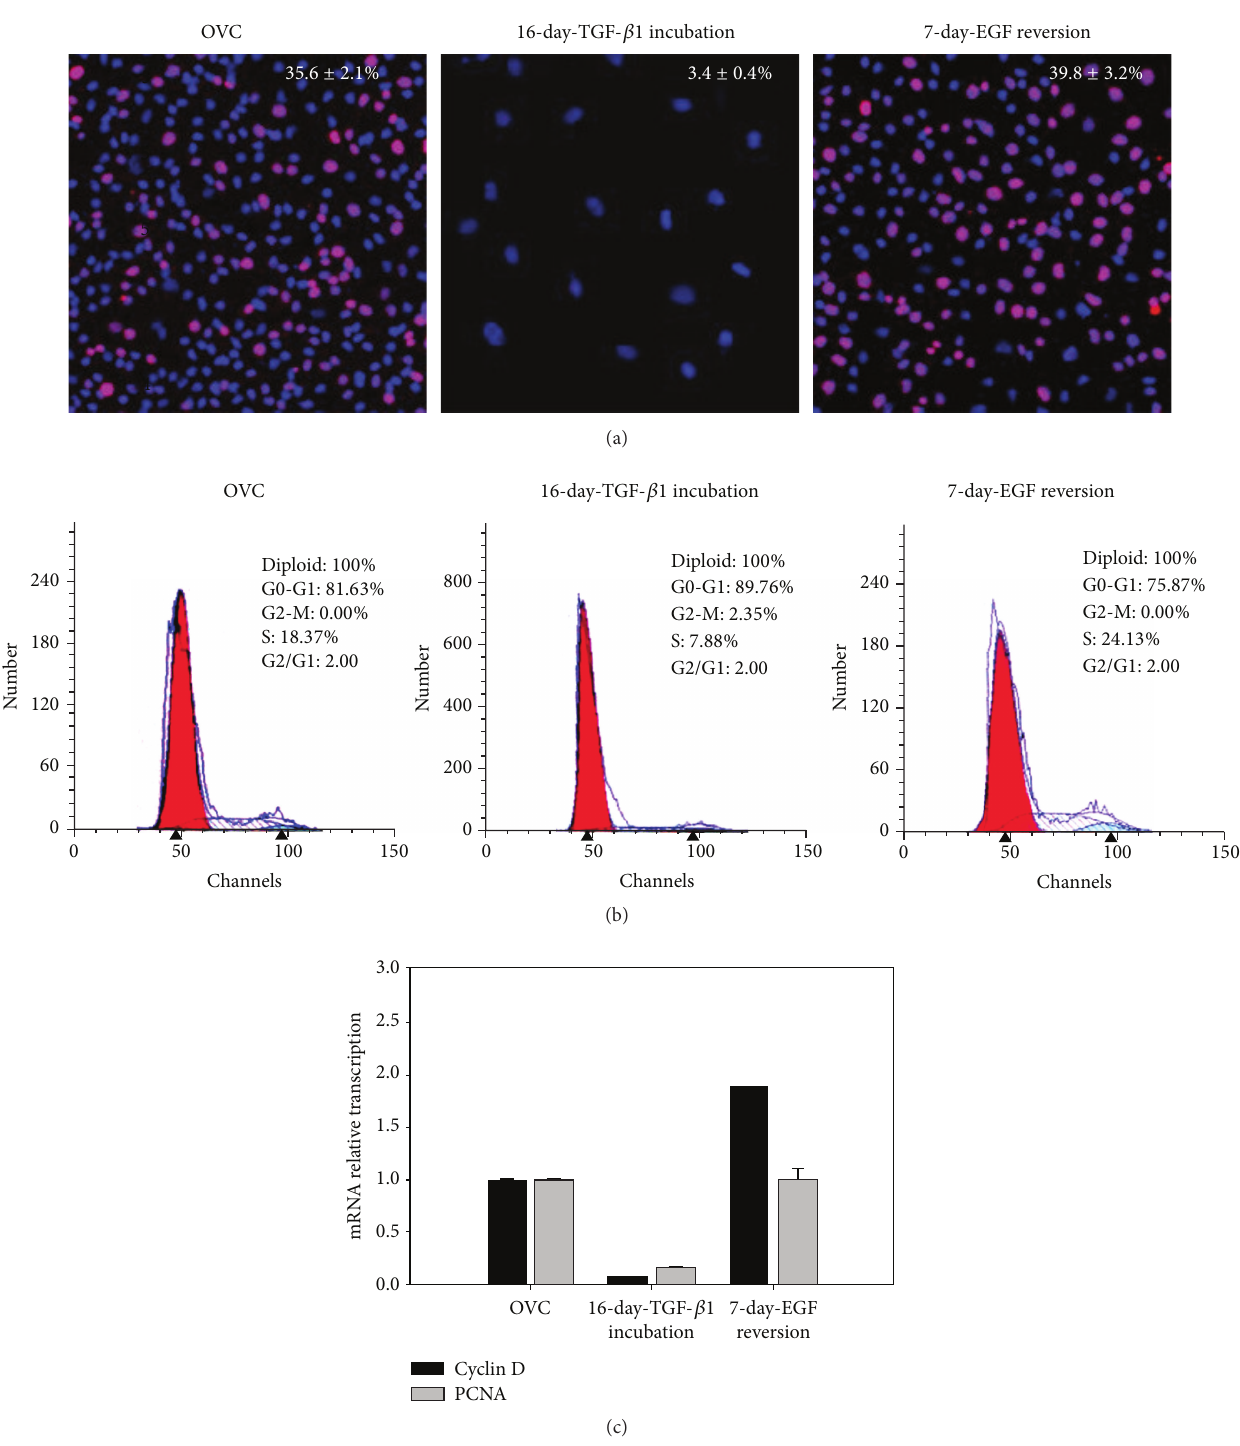
Figure 3: Seven-day EGF incubation restores the proliferation capacity of hepatic oval cells, which could be inhibited by TGF- 𝛽 1. (a) Sixteen- day TGF- 𝛽 1 incubation significantly reduced Ki-67 positive rate of hepatic oval cells; 7-day EGF incubation of 16-day TGF- 𝛽 1-pretreated cells returned the Ki-67 positive rate to levels comparable to control cells. (b) Cell-cycle analysis by PI staining further demonstrated the rescue effects of 7-day EGF incubation on cell proliferation of 16-day TGF- 𝛽 1-pretreated cells. (c) Real-time PCR analysis showed that 16-day TGF- 𝛽 1 incubation reduced cyclin D and PCNA transcription, while 7-day EGF reversion could increase the mRNA transcription of cyclin D and PCNA to the level of control